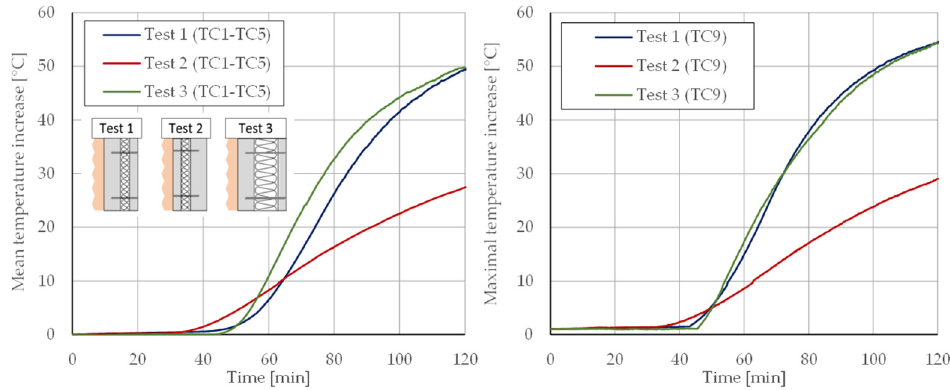
Figure 9. The mean temperature increases on the side not exposed to fire.